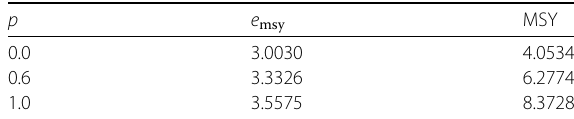
Table 12 The values of the maximum sustainable yield (MSY) and maximum effort ( e msy ) for different values of the parameter p when both predators (middle predator and top predators) are harvested from the